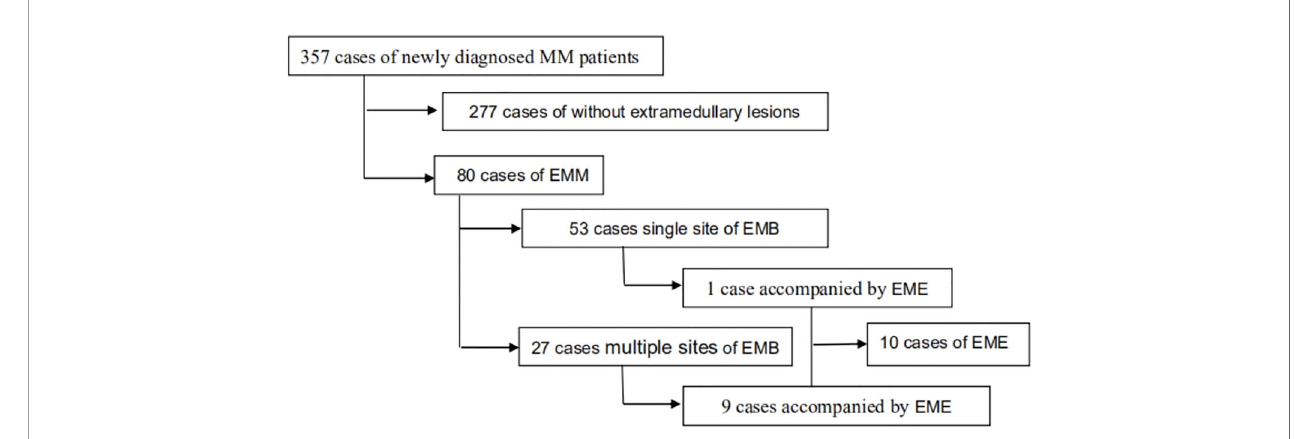
FIGURE 1 | Schematic diagram of EMM patient